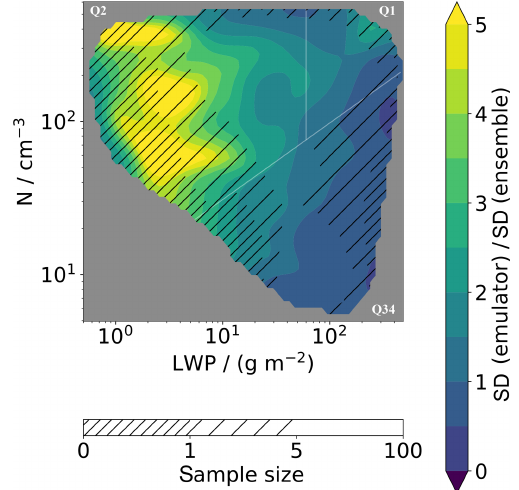
Figure 8. Comparison of errors from emulation, ensemble, and sampling. Contours show the ratio of emulator and ensemble stan- dard deviation (SD) and hatching shows the sample size as in Fig. 7. Note that sample sizes smaller than one trajectory can occur due to